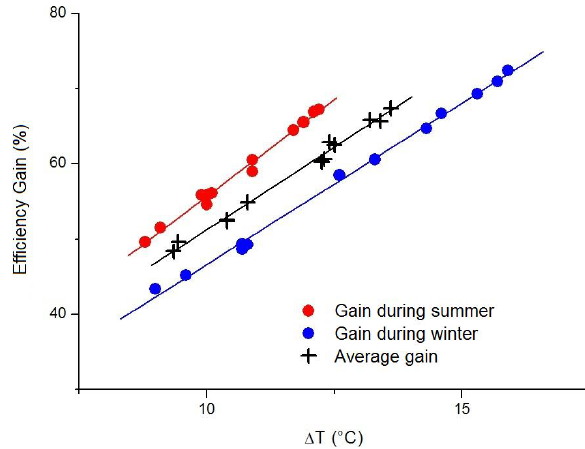
Figure 10: Efficiency gain as function of ∆T = T